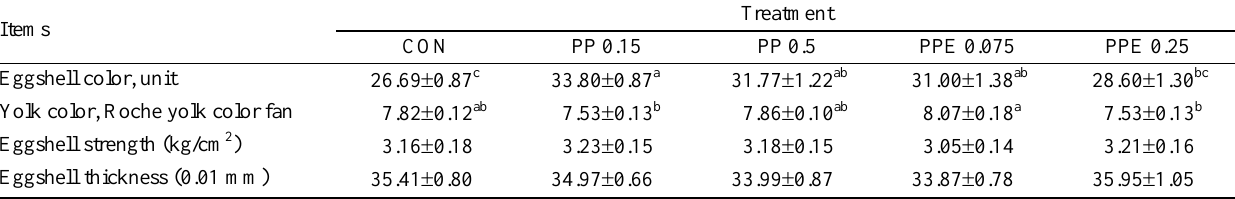
Table 3. Effects of persimmon peel (PP) and persimmon peel ethanol extract (PPE) on egg quality in laying hens 1